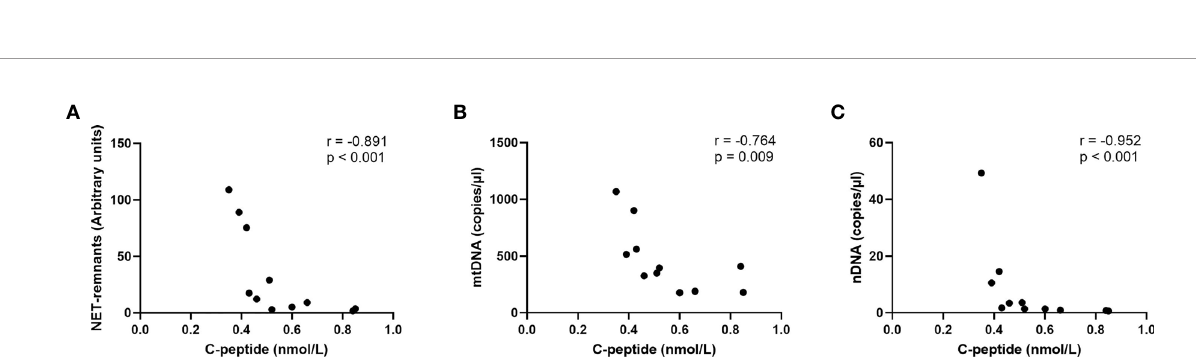
FIGURE 5 | Healthy children compared with children at high risk of T1D at fi ve time points for NETs (A) , mtDNA (B) and nDNA (C) (Mann-Whitney test). Comparison over time within the high-risk group was done using Kruskal-Wallis test followed by Dunn ’ s multiple comparisons test (A – C) .